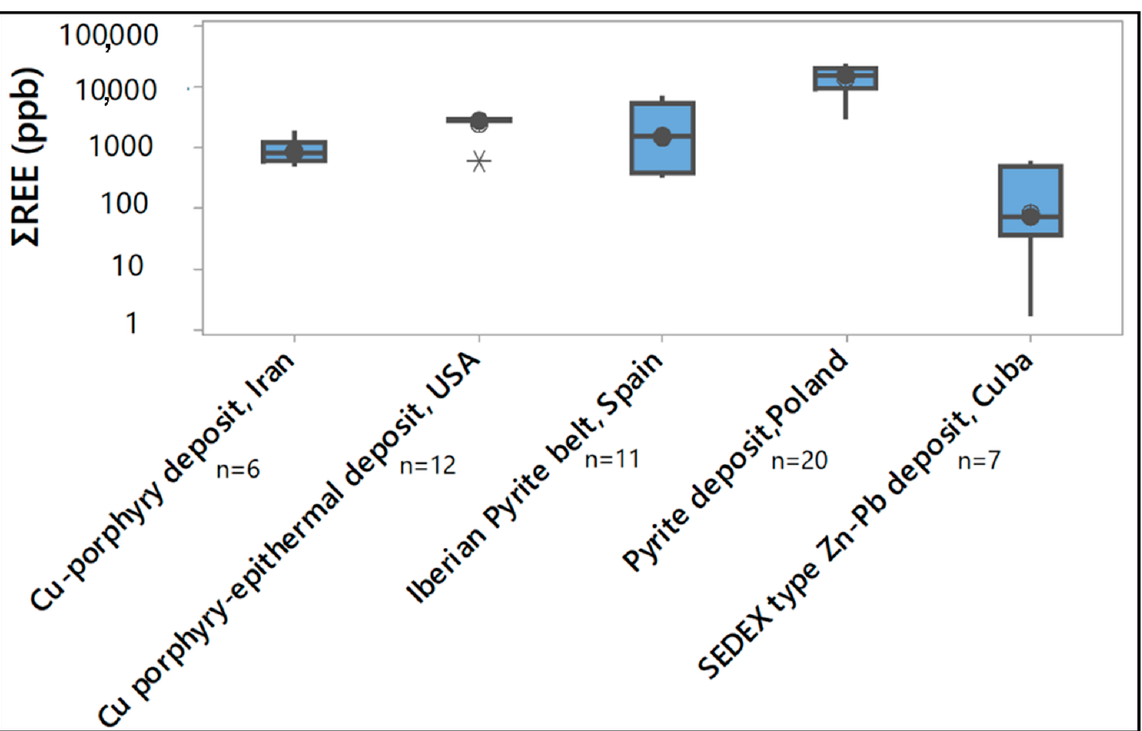
Figure 5. Boxplots of REEs concentration in mine waters from different ore deposits (*: outlier values) .